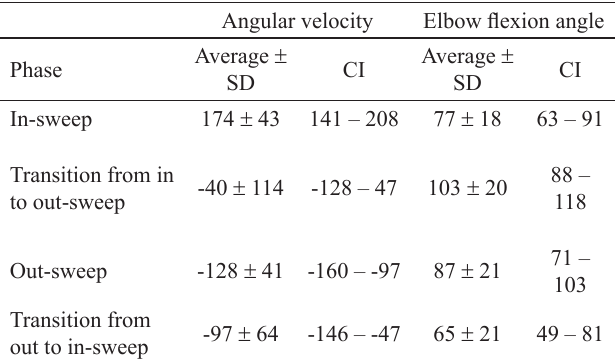
5. Average, standard deviation (SD), lower and upper boundaries of confidence interval (CI) of angular velocity of elbow (degree/s) and elbow flexion angle (degree) for each phase of the average cycle.